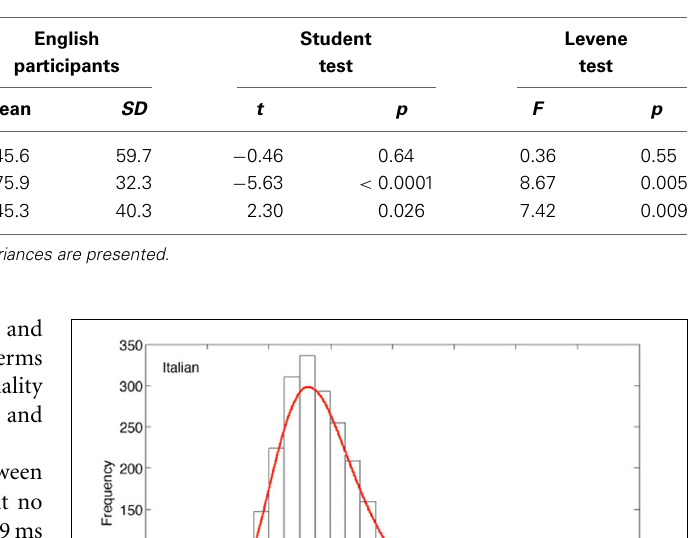
Table 5 | Means (and standard deviations) for the ex-Gaussian parameters of Italian and English participants across experimental conditions of Experiment 3.